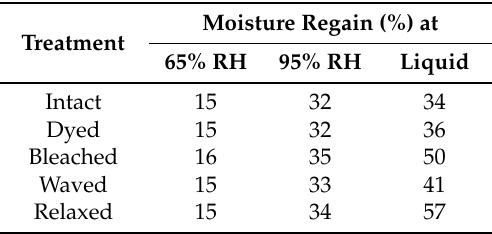
Table 3. Effect of hair treatment on moisture uptake by hair